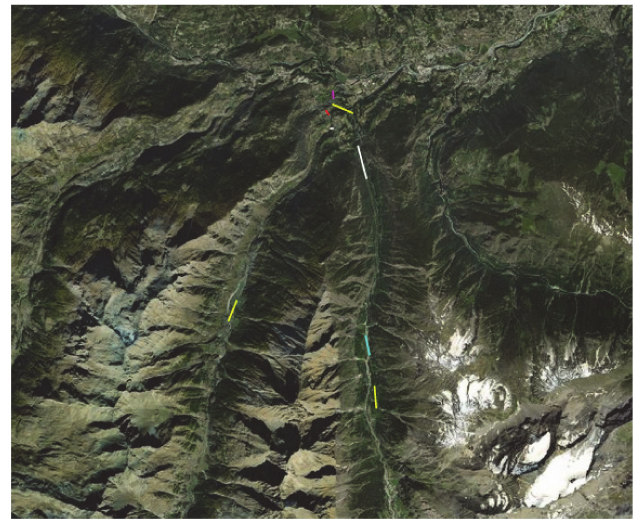
Figure 3. Map of the components with the highest failure probabilities, case A1. The colour legend is the following: magenta is associated with probabilities between 1 and 0.8, red to probabilities between 0.6 and 0.8, yellow to probabilities between 0.4 and 0.6, while cyan to probabilities between 0.2 and 0.4 and white to probabilities lower than 0.2. Figure 4 indicates the actual mechanical tensions produced by the storm (blue dots) on the MV and HV lines of the T&D system with their relevant rated tensile strength (indicated with red squares).